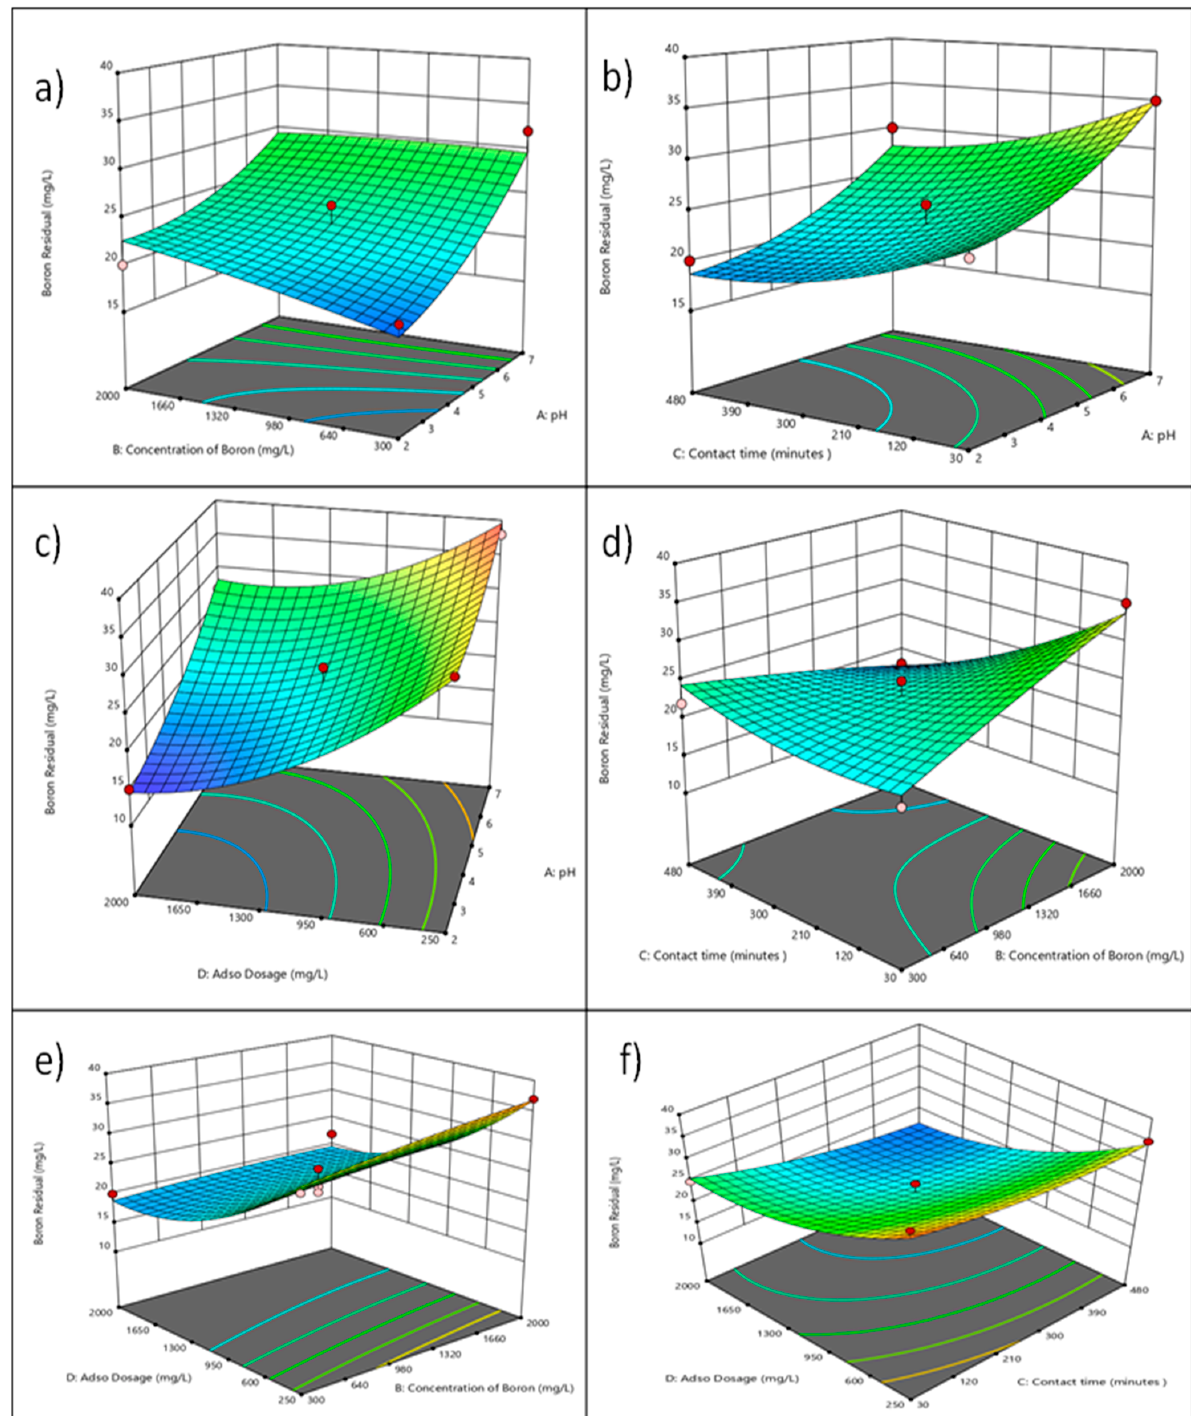
Figure 6. Interaction of ( a ) Initial Concentration and pH (3D surface); ( b ) Time and pH (3D surface); ( c ) Adsorbent Dosage and pH (3D surface); ( d ) Time and Initial concentration (3D surface); ( e ) Adsor- bent Dose and Initial Concentration (3D surface); ( f ) Adsorbent Dosage and Time (3D